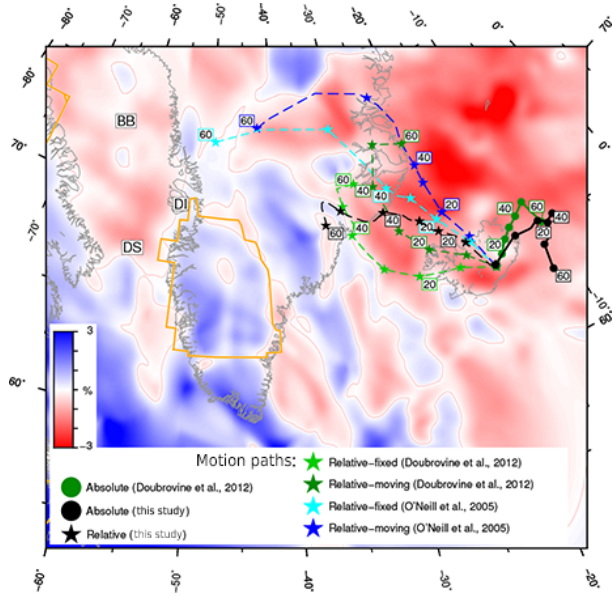
Figure 6. (a) Reconstructed absolute motion paths of the Iceland plume (solid bold circles) and its reconstructed relative motion paths to Greenland (solid smaller stars). Black: model motion paths (Sect. 2.2.3) from this study; green: motion paths of Doubrovine et al. (2012); blue: motion paths of O’Neill et al. (2005). Underlain is the 150km depth slice of a P wave velocity model (Jakovlev et al., 2012) presented in Rogozhina et al. (2016), showing the veloc- ity model beneath Baffin Bay and Davis Straight and Greenland, colour-mapped for percentage velocity anomaly. DI: Disko Island; BB: Baffin Bay; DS: Davis